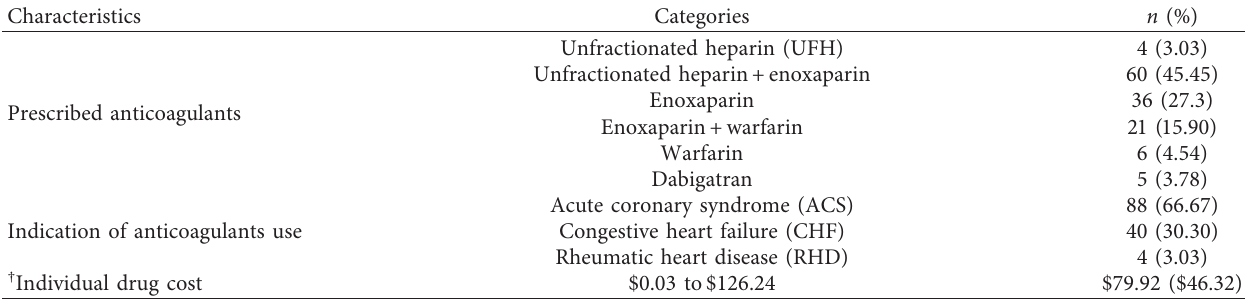
Table 2: Anticoagulant use and cost in the cardiology unit ( n � 132).